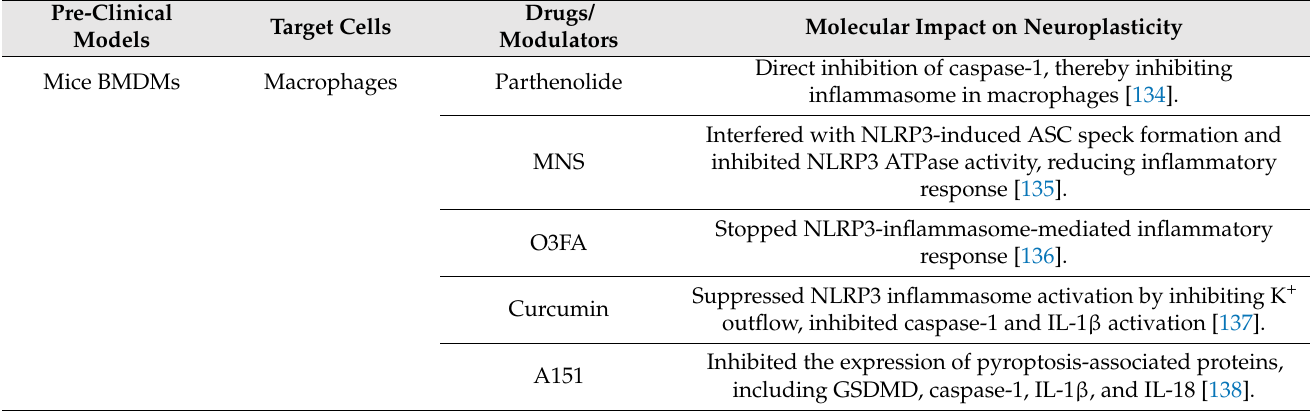
Table 2. NLRP3 inflammasome modulators for ischemic stroke